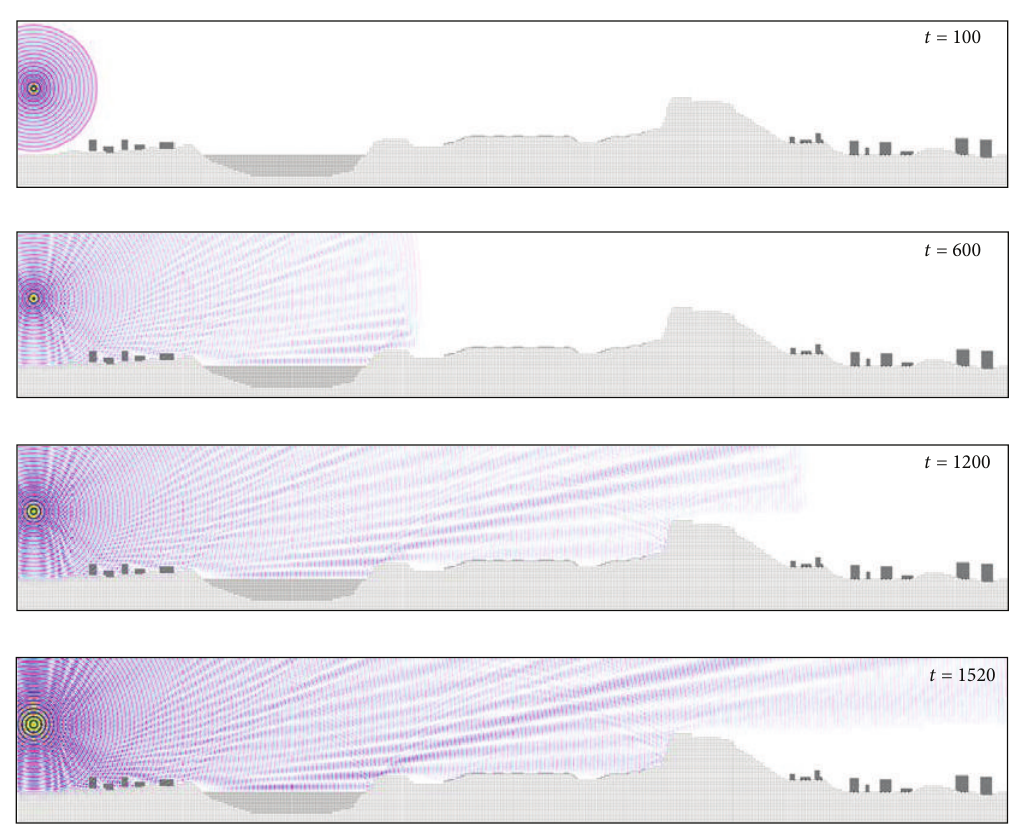
Figure 4: Spatial pattern 𝑈(𝑔,𝑡) , 𝑔 ∈ Ω int taken at various fixed moments 𝑡 when the quasi monochromatic signal with central frequency ̃𝑘 = 1.0 is travelling